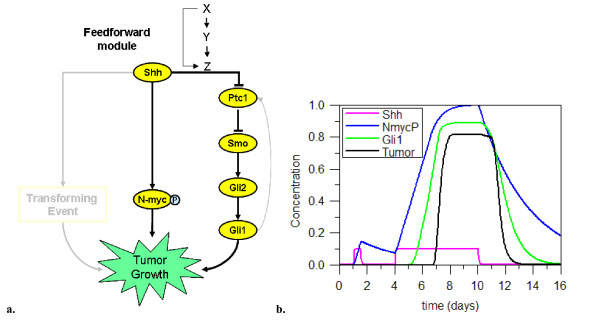
a. A feedforward motif in the hedgehog pathway is highlighted. b. To isolate the dynamics of the feedforward motif, the transforming event was made constitutively "on" and the Gli1 feedback loop to Ptc1 was deleted. A short, half-day upregulation of Shh was given at the start of day 1, then turned off. Though NmycP responded quickly to this transient signal, it was not sufficient to activate Gli1 transcription. Shh was upregulated for a longer period starting on day 4. After a one day delay, Gli1 transcription commences. Tumor growth begins when Gli1 reaches a moderately high level. When Shh transcription ends, NmycP levels begin to drop immediately, but Gli1 decline is delayed. Thus, a series of prolonged aberrant Shh activation events could sustain tumor growth.